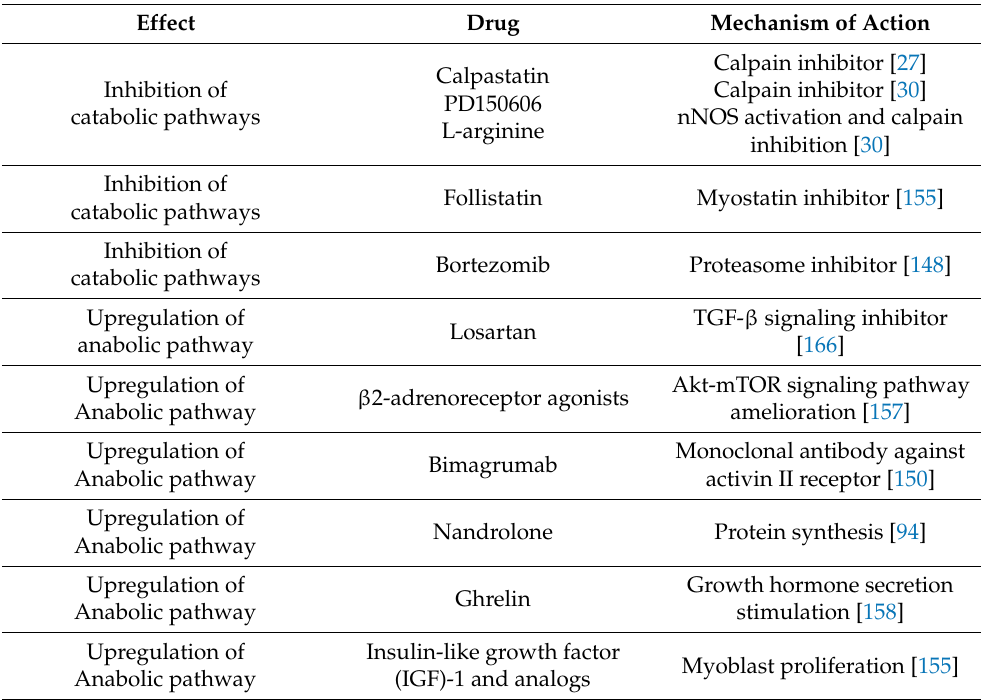
Table 1. Drugs and compounds with pharmacological action able to prevent or restore muscle atrophy in different physiopathological situations. Pharmaceutical Compounds That Could Prevent or Restore Muscle